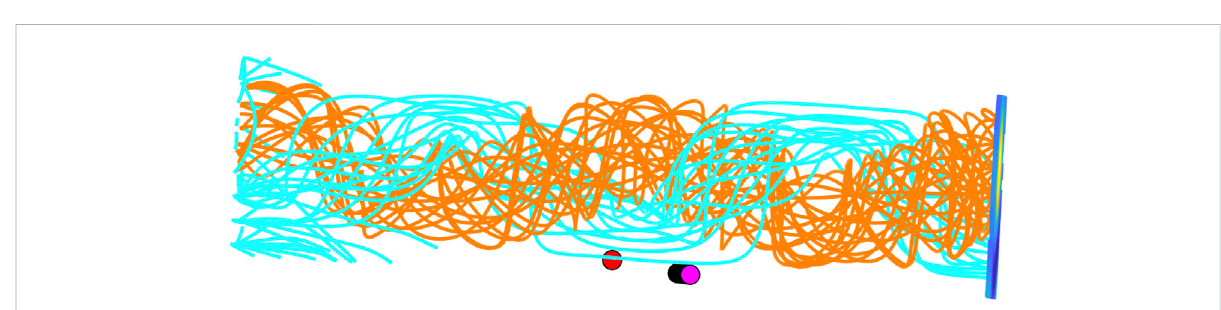
FIGURE 6 A rendering of the magnetic fi eld lines of the optimal FS model result based on the fi tting to the STA-only data interval in a view from the STA ’ s perspective.The fi eldlinesinorangearerootedinthepositive B z polarityregionwhilethecyanlinesarerootedonthenegativepolarityregiononthe bottom cross section plane which is equivalent to the one given in Figure 5. The view is directly along the STA ’ s path (the -R direction) as denoted by the red dots toward the Sun (the N direction is straight up), and the PSP path is marked by the magenta dots to the